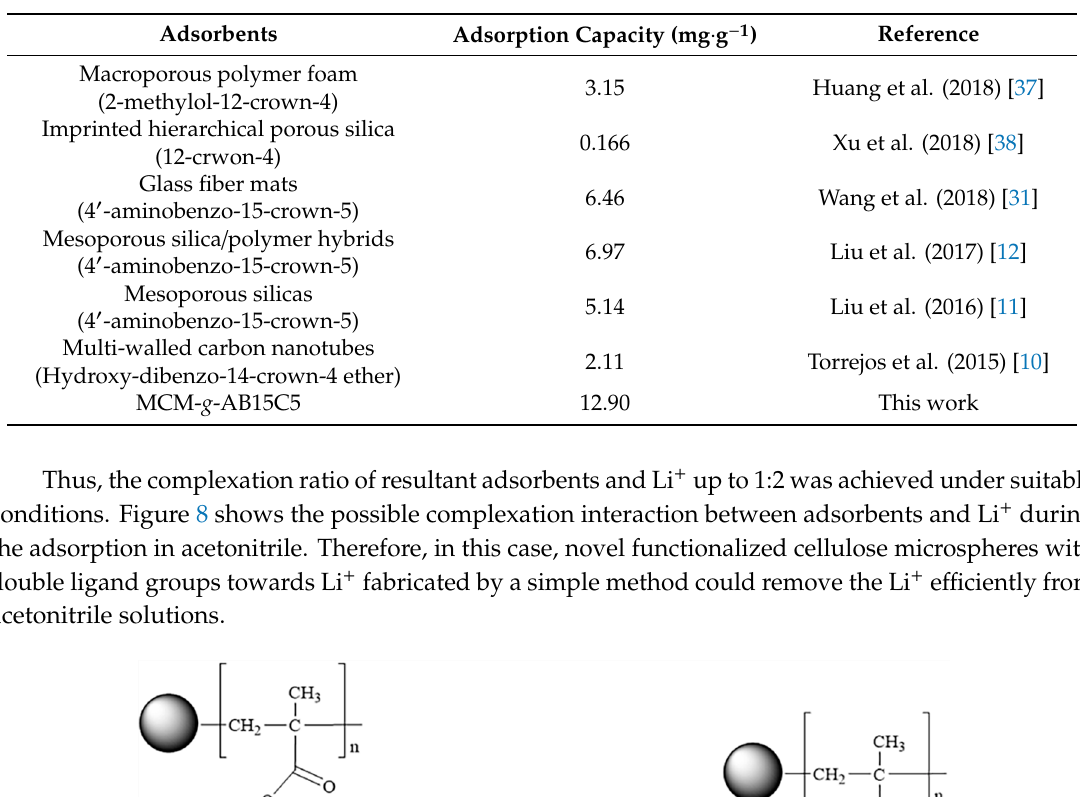
Table 2. Comparison of adsorption capacity of MCM- g -AB15C5 with the published adsorbents for Li + .